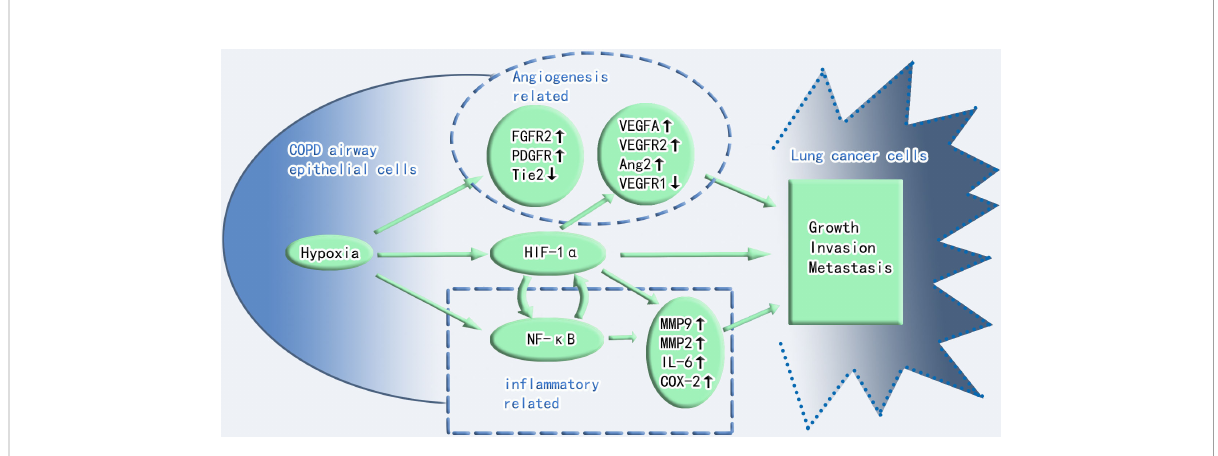
FIGURE 1 Crosstalk between hypoxia and in fl ammation in COPD and lung cancer toxicity. Angiogenesis, HIF-1 a , and in fl ammation play important roles in the progression of COPD to lung cancer. Angiogenesis and in fl ammation cross-talk through HIF-1 a . FGFR2, fi broblast growth factor receptor 2; PDGFR, platelet-derived growth factor receptor; Tie2, Tie2 (a member of the receptor tyrosine kinase family and the receptor for angiopoietin); VEGF-A, vascular endothelial growth factor-A; VEGFR2, vascular endothelial growth factor receptor 2; VEGFR1, vascular endothelial growth factor receptor 1; Ang2, angiopoietin-2; NF- k B, nuclear factor kappa B; IL-6, interleukin-6; COX-2, cyclooxygenase 2; MMP9, matrix metalloproteinase-9; MMP2, matrix